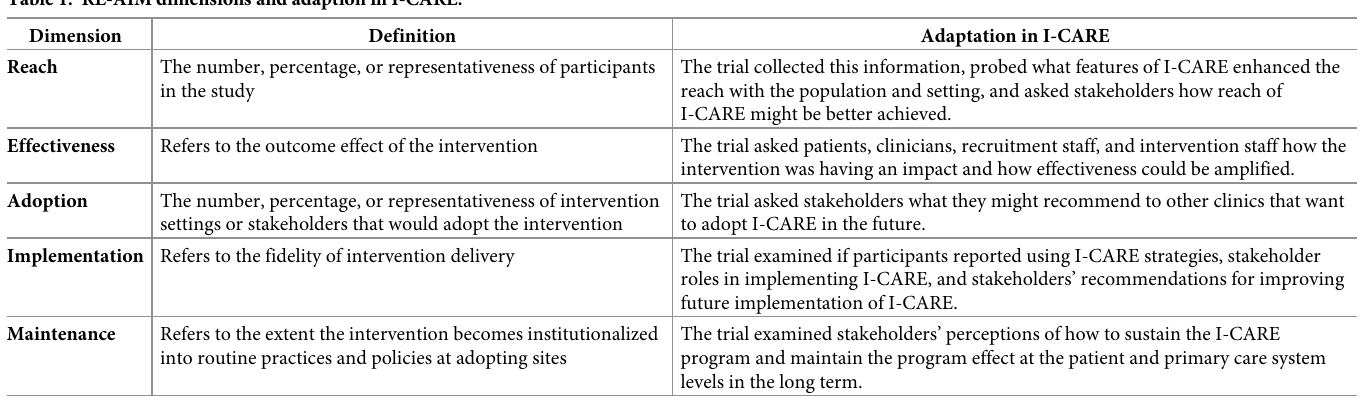
Table 1. RE-AIM dimensions and adaption in